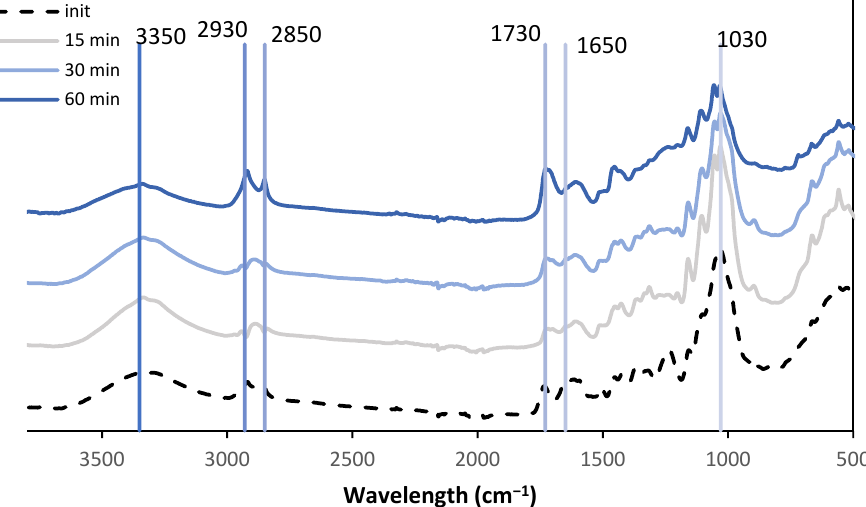
Figure 7. FTIR spectra of the initial material and of the solid residue obtained by liquefaction at 180 °C for 15 min, 30 min and 60 min reaction time with acid catalysis.